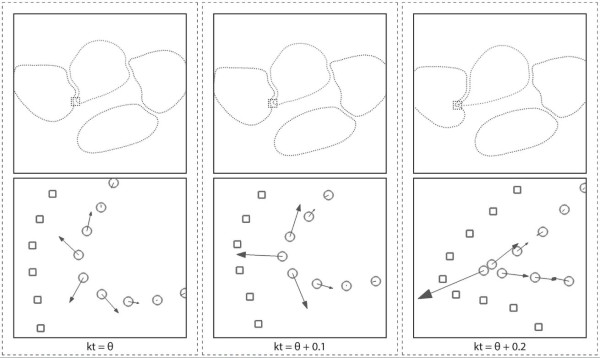
Instantaneous profiles of the RBC membrane buckling under channel flow conditions. The progression of the membrane pinching is shown in sequential frames as indicated by the dimensionless time kt. θ denotes the time at which the onset of pinching was observed. The bottom panel of images provide a zoomed-in view of the pinched region where an increasing force in the adverse direction contributes to the growing instability that finally leads to membrane buckling and twisting.